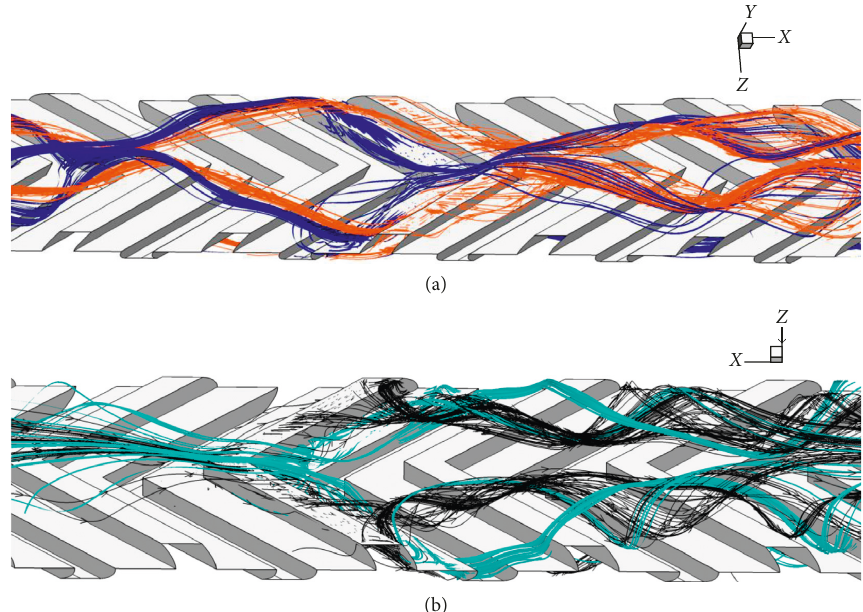
30 ° and Re 600 for (a) V- (cid:28) (cid:28)